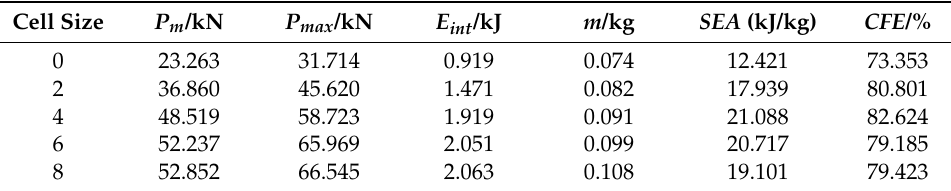
Figure 12. Comparisons of absorbed energy properties of BHS-1 with different filling honeycombs size: ( a ) crushing force versus displacement curves; ( b ) absorbed energy versus displacement curves. Table 2. Energy-absorbing behaviors of BHS-1 with different cell size.